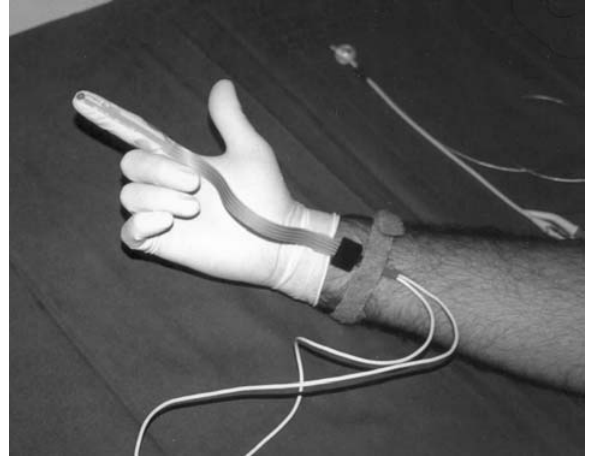
Figure 1 – St. Mark’s pudendal electrode stands out in the uroneurophysiology lab. Electrode of stimulation and registra- tion sites, respectively, at the tip and base of the index finger. A distance of 3 cm separates the registration electrodes from the stimulation